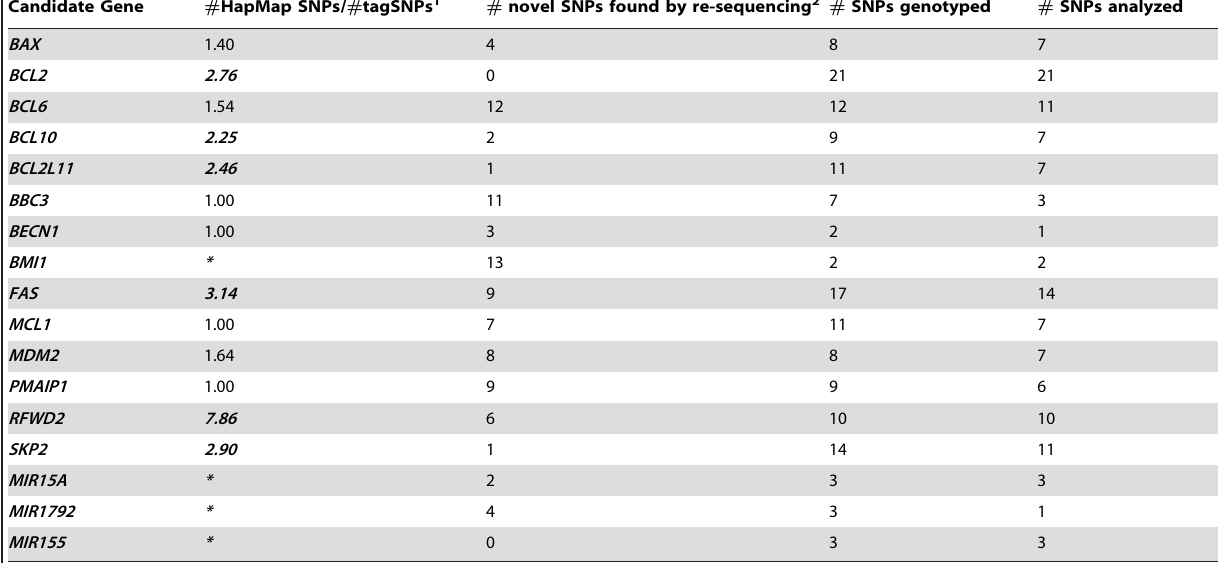
Table 2. Candidate